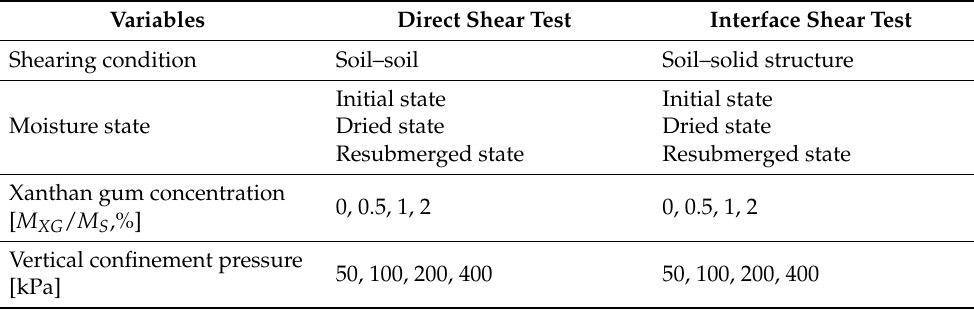
Table 3. Experimental